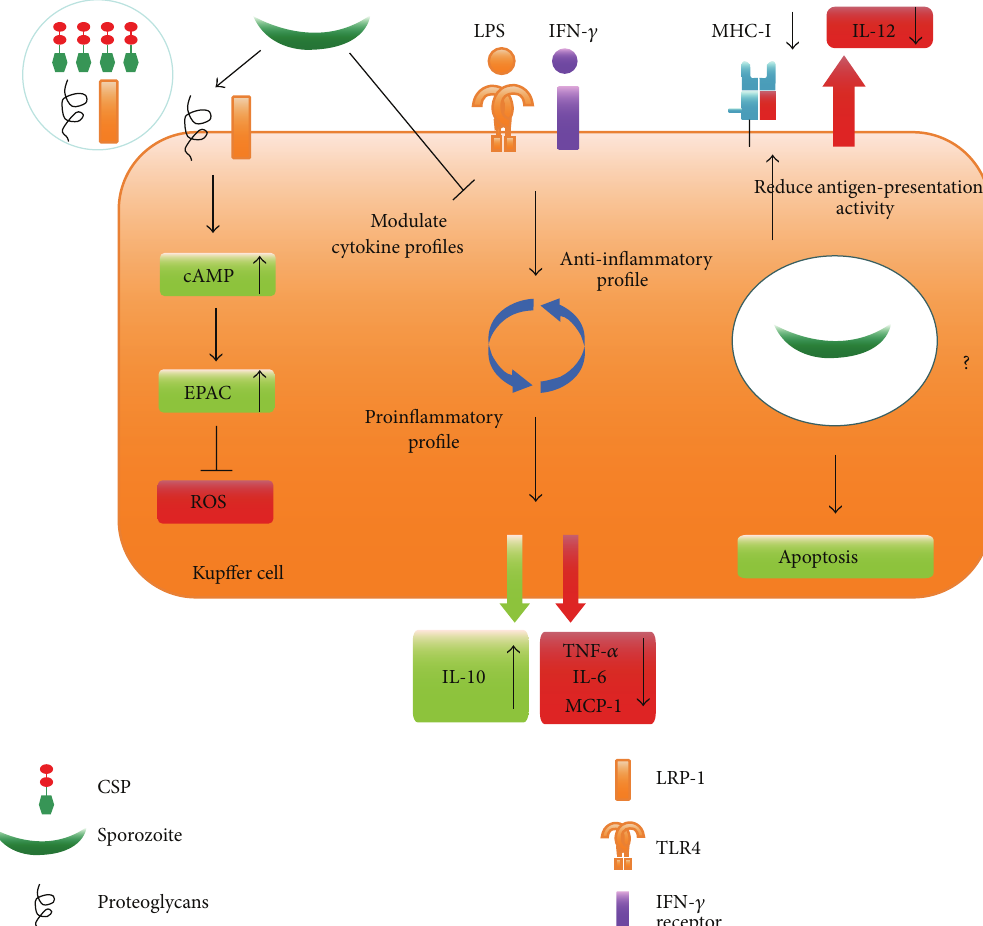
Figure 1: Sporozoites suppress the function of KCs. The binding of sporozoite CSP to proteoglycans and LRP-1 upregulates cAMP/EPAC and prevents the formation of ROS (left). Exposure to sporozoites downregulates the inflammatory cytokines TNF- 𝛼 , IL-6, and MCP-1 and upregulates the anti-inflammatory cytokine IL-10 after stimulation with IFN- 𝛾 or LPS (middle). Sporozoite infection also downregulates MHC I and IL-12p40 and induces apoptosis in KCs